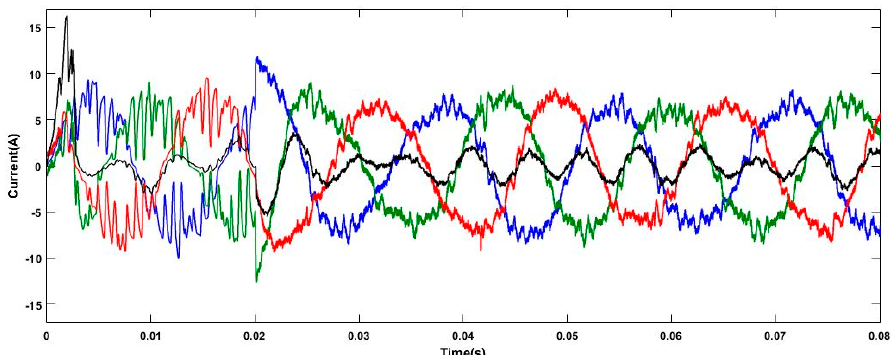
Figure 16. Compensation result with the sliding DFT for case 3. Energies 2019 , 12 , x FOR PEER REVIEW